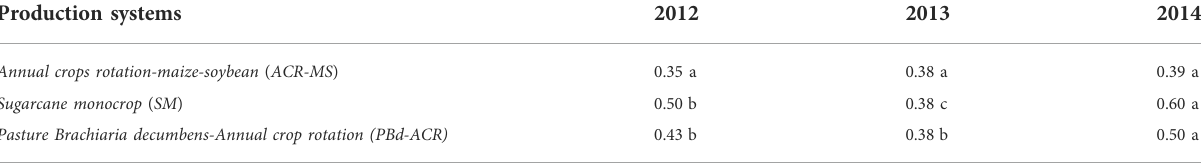
TABLE 10 GHG indicator valued in the productive systems established in an Oxisol of the Meta High